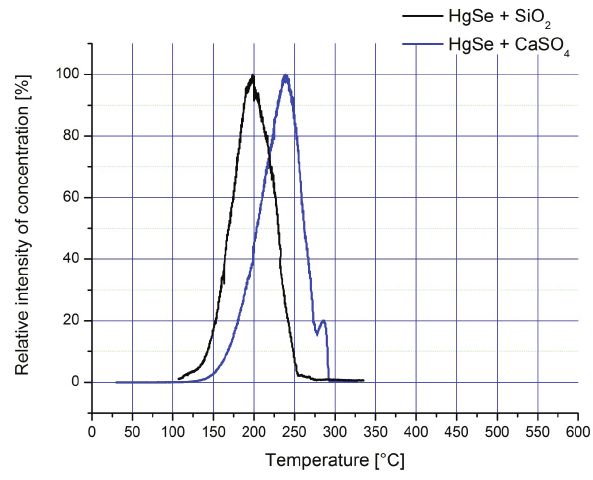
Figure 19: Thermograms of HgSe mixtures, obtained by MS.